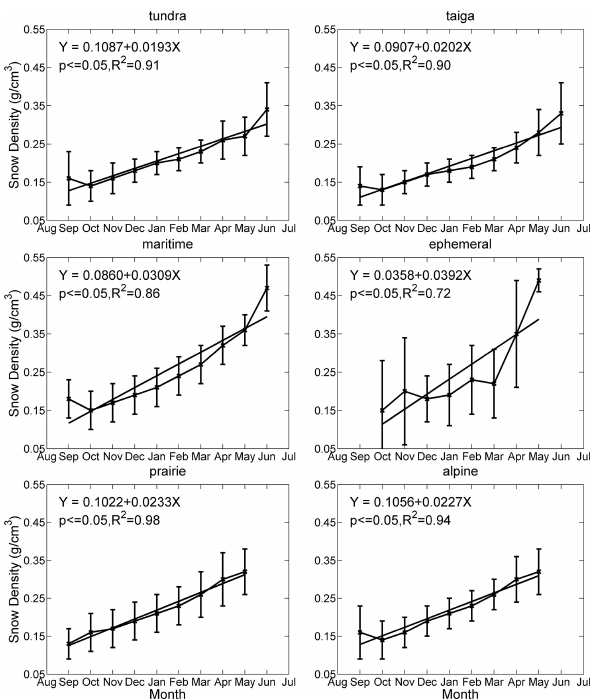
Fig. 6. Monthly mean snow density for tundra, taiga, maritime, ephemeral, prairie, and alpine snow. The asterisk is the computed monthly mean snow density; the error bar represents one standard deviation from the mean over the entire period. The thick line is a linear regression trend. In the equation, y stands for snow den- sity ingcm − 3 , and x for time in months (from September to June). September was the first month in a snow cover year, therefore, x ranged from month 1 (September) to month 10 (June) in the sim- ulation of monthly snow density. p is the confidence level for the coefficient estimates, and R 2 is the goodness of fit coefficient.